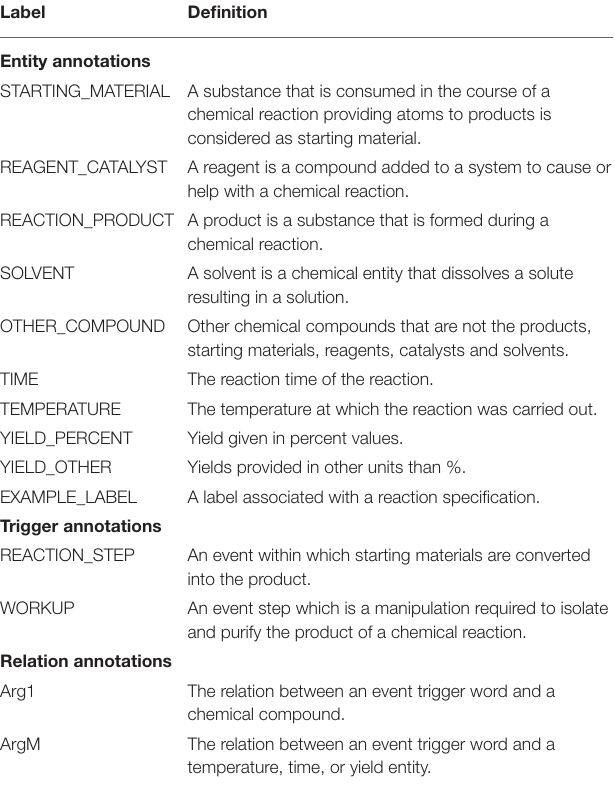
TABLE 2 | Definitions of entity, trigger word, and relation types, i.e.,